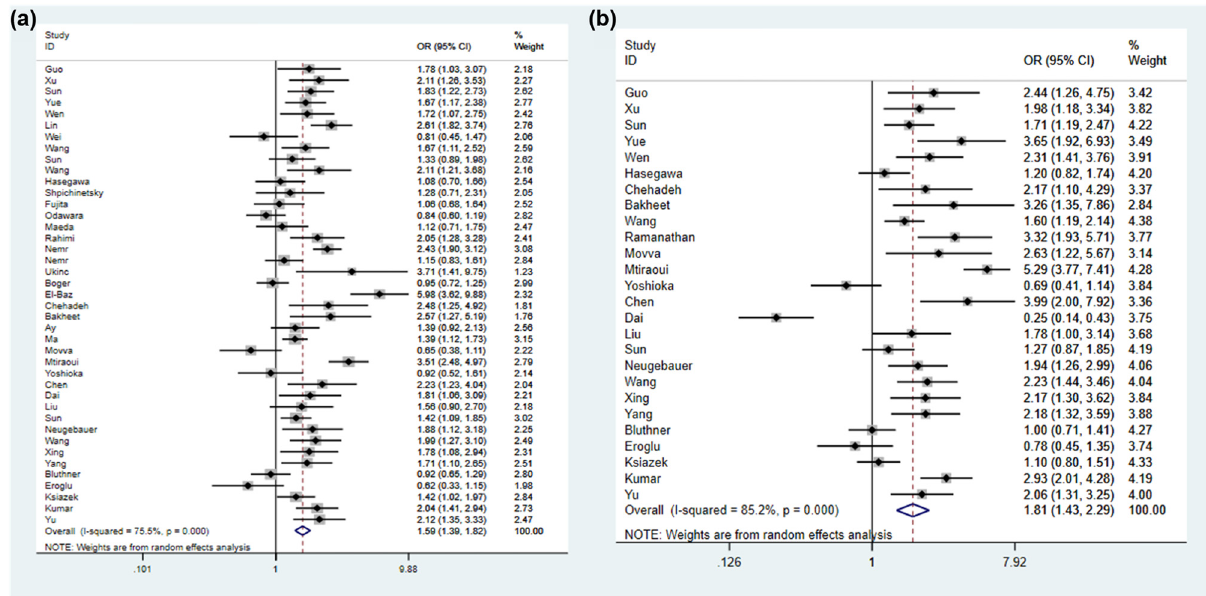
Figure 2: Forest plots of the overall DN risks associated with MTHFR C677T polymorphism in allele model. ( a ) Comparison with DM controls and ( b ) comparison with healthy controls.